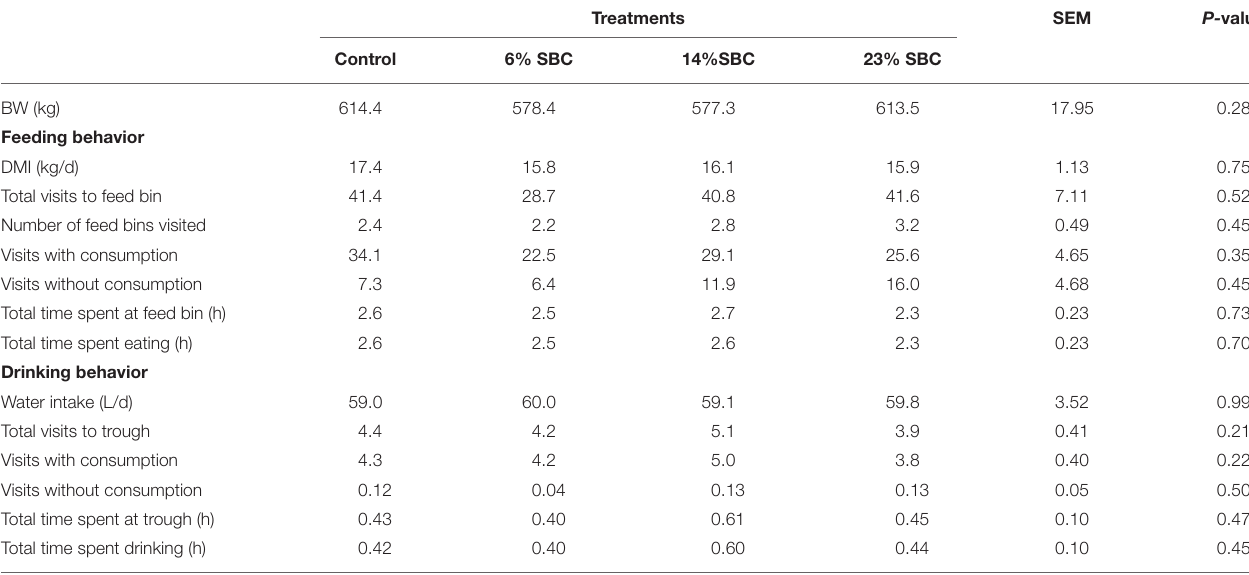
TABLE 2 | Effect of replacing soybean meal (SBM) with soybean cake (SBC) on dry matter intake (DMI), feeding behavior, water consumption, and body weight (BW) in dairy cattle.